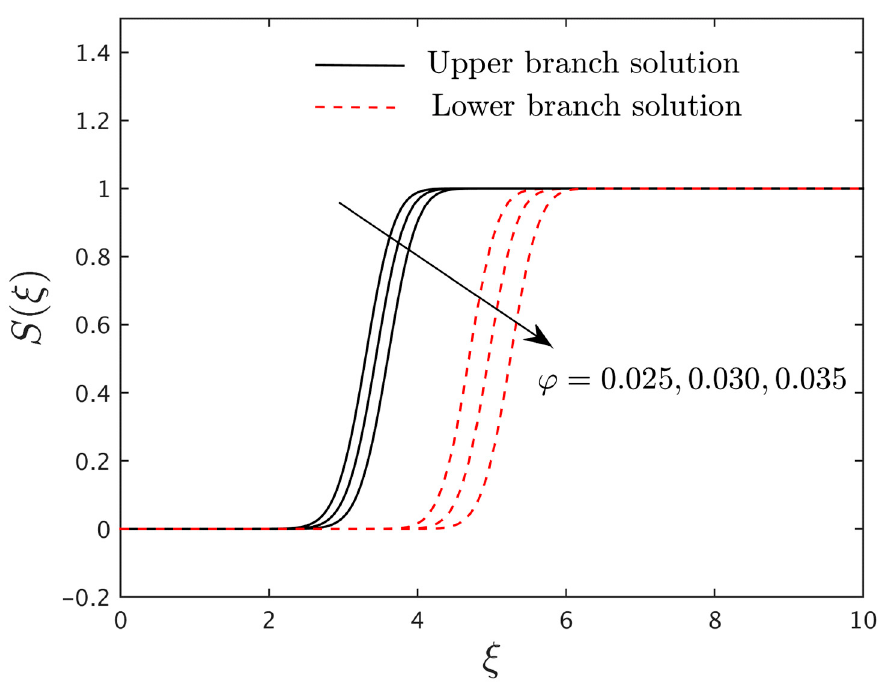
Figure 12. The concentration profiles S ( ξ ) for the numerous values of ϕ when Pr a = 1.0, Sc a = 10.0, Pr = 6.2, Σ a = 0.05, and γ s =